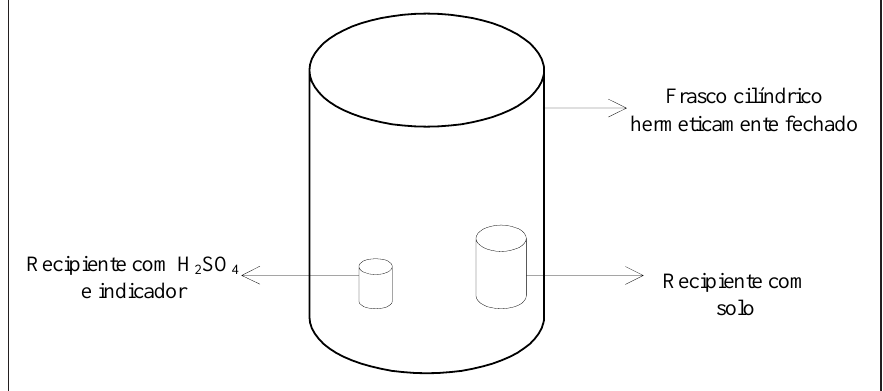
Figura 1. Representação esquemática do sistema utilizado na coleta da amônia volatilizada.